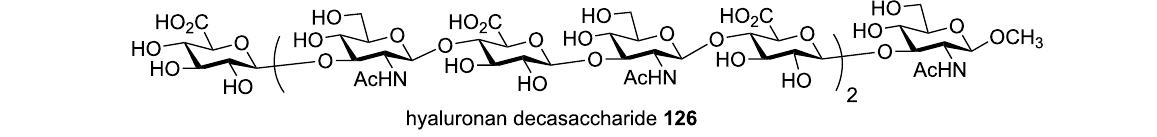
Figure 7: Some representative mammalian oligosaccharides synthesized by the preactivation-based thioglycoside method.